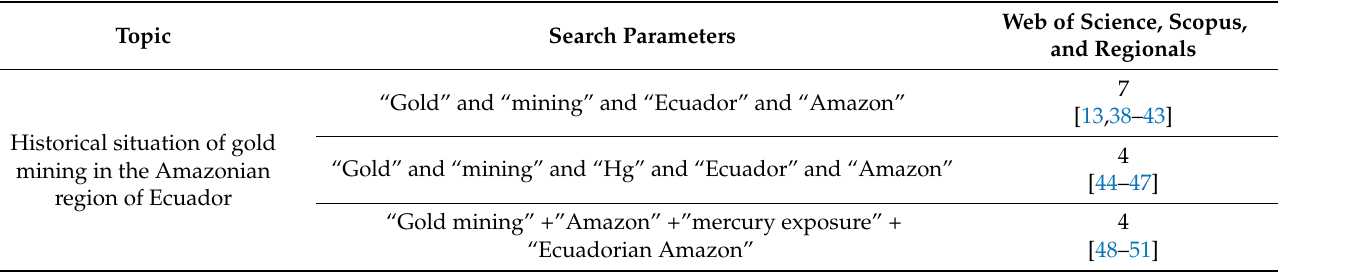
Web of Science, Scopus,